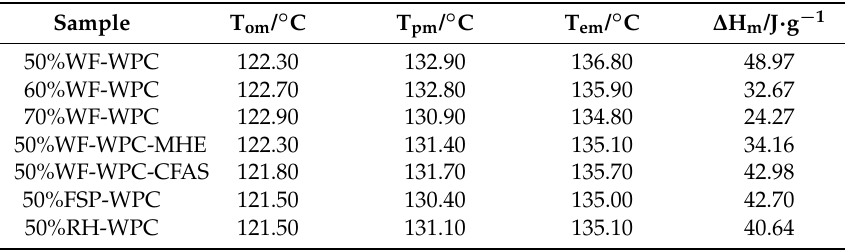
Table 3. Characteristic data of the WPCs’ melting curves.